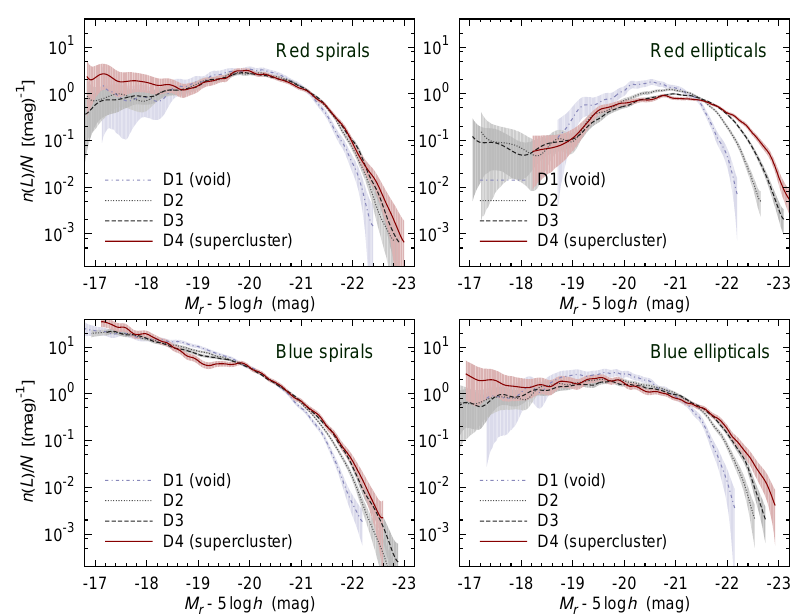
Fig. 4. Attenuation-corrected LFs for red ( upper panels ) and blue ( lower panels ) populations; for spirals ( left panels ) and ellipticals ( right panels ), in different global environments. The shaded areas show the 95% confidence regions of the